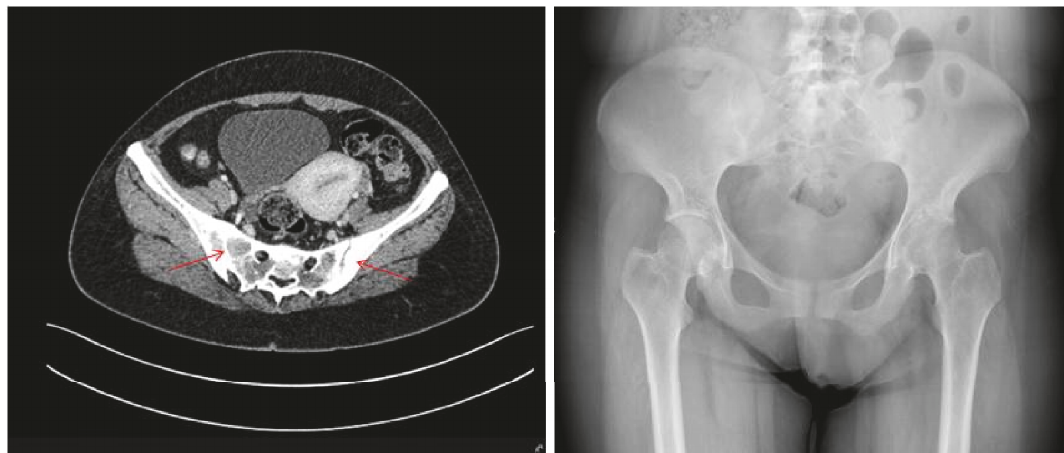
Figure 3: MRI and X-ray of sacroiliac joints showing total ankylosis of the right sacroiliac joint and partial ankylosis with irregularity on the nonsclerotic segments of the left sacroiliac joint (grade 3-4 sacroiliitis).